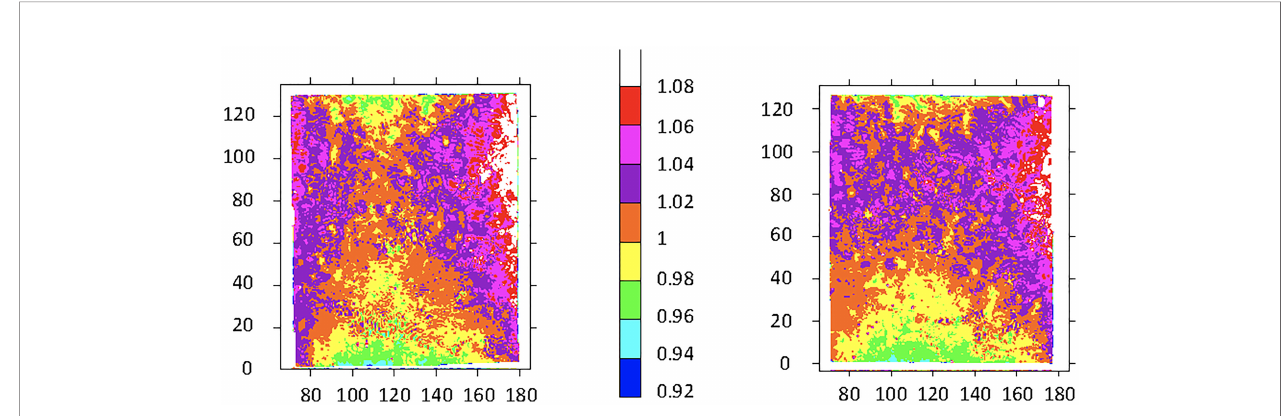
FIGURE 3 | Test fi lm results from two OCs exposed to 150 Gy. The target dose delivered was 150 Gy. The color scale represents proportional arbitrary scanning laser densitometry units normalized to 312 SLD units left, and to 320 SLD units right. The boundary between orange and yellow was assigned a value of 1. Horizontal axis: units in mm relative to the scanner base plate; vertical axis: distance in mm from the bottom of the fi lm/container. See Figure 2 for the minimum dose locations (position F, bottom center of each fi lm) and maximum dose locations (position H, at the side wall equator of each fi